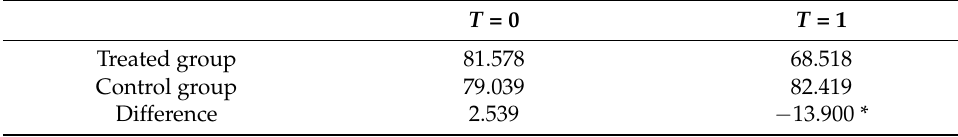
Table 2. Differences of AQI between January to April 2019 and January to April 2020. T = 0 T = 1 Treated group 81.578 68.518